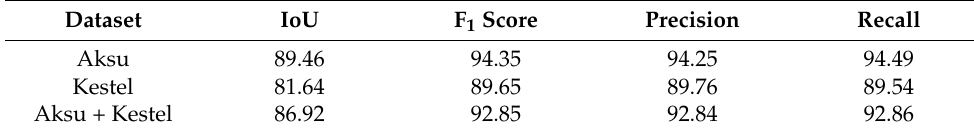
Figure 6. Comparison of visual results of predictions from different encoders. ( a ) Input images, ( b ) Ground truth data, ( c ) Resnext50_32x4d results, ( d ) Resnet50 results, ( e ) DPN-68 results, ( f ) Mo- bilenetv2 results, and ( g ) Efficientnet-B2 results. Table 4. Comparison of segmentation results on different